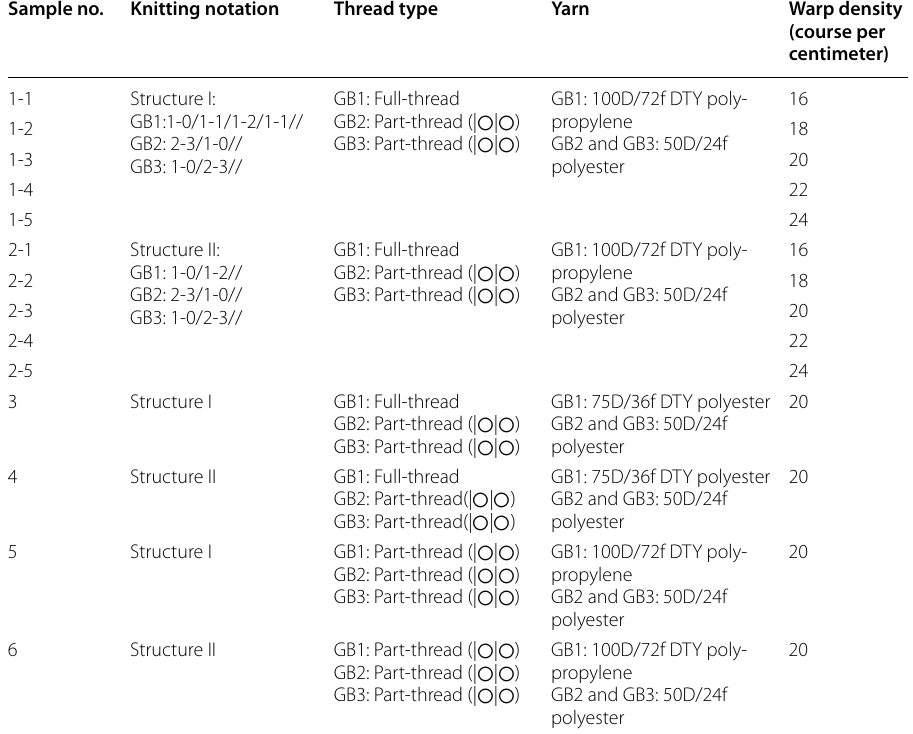
Table 1 The sample preparation Sample no.